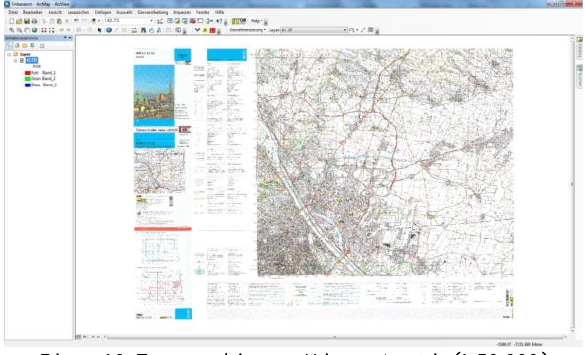
Figure 10. Topographic map, Vienna, Austria (1:50,000)